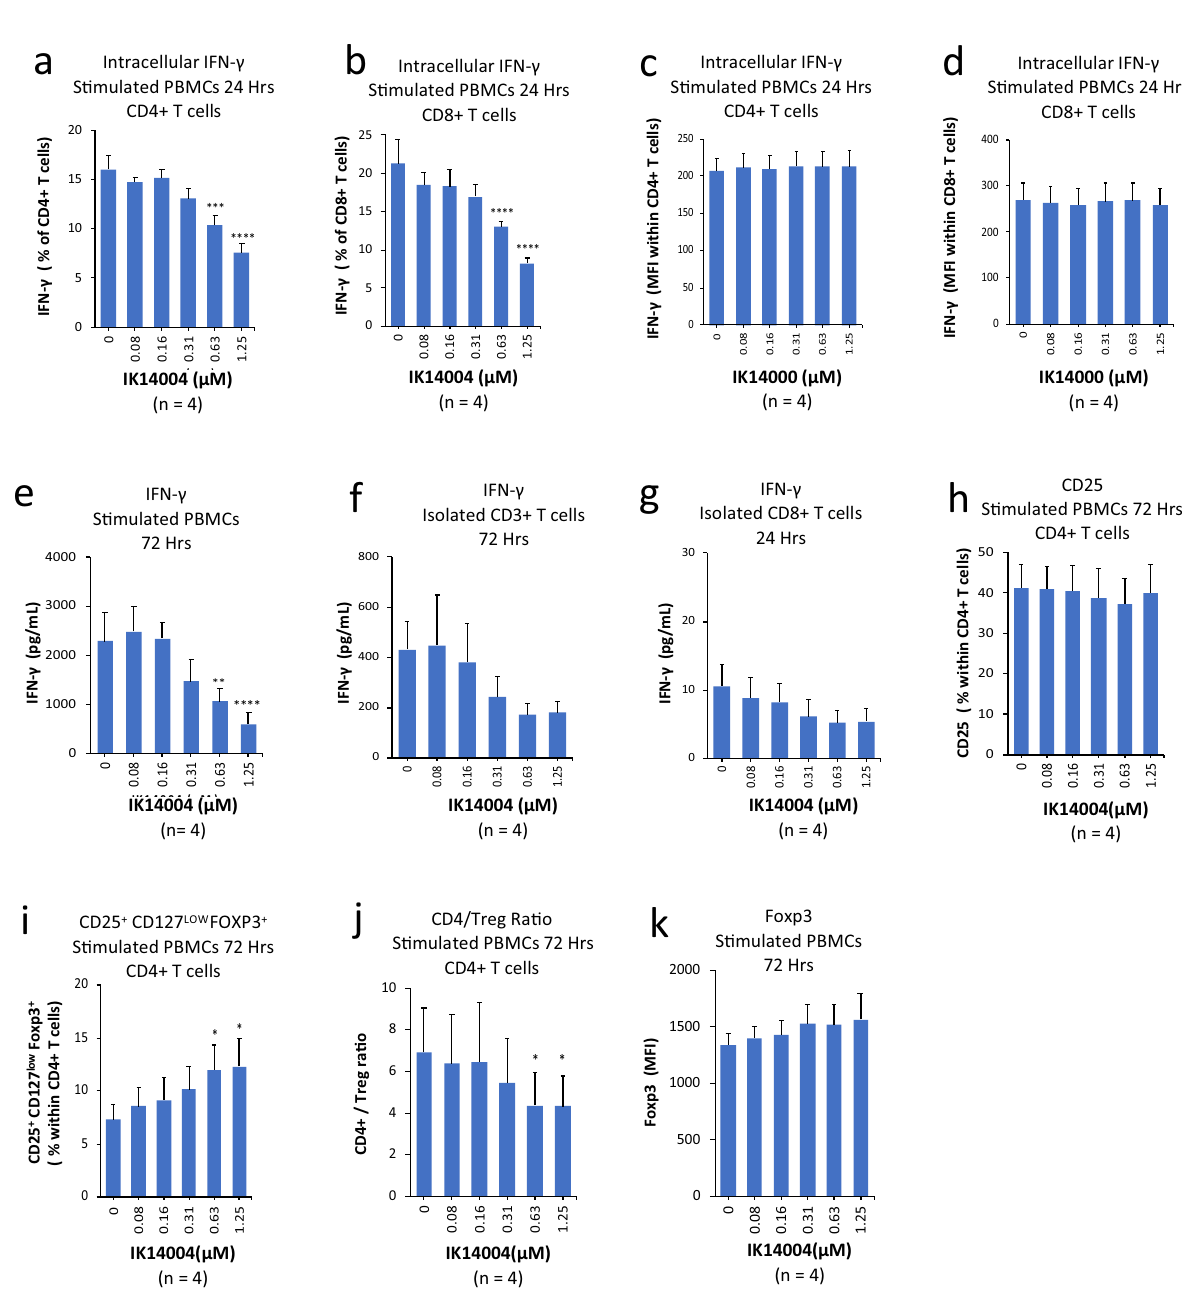
Figure 5. IK14004 inhibits IFN-γ expression and increases the proportion of T regulatory (Treg) cells. Stimulated PBMCs, isolated CD3+ T cells, or isolated CD8+ T cells were cultured in triplicate wells in each experiment. Each experiment was repeated four times (n = 4) as shown below each panel. Both flow cytometry and ELISA assays were conducted to assess IFN-γ expression either after 24 or 72 h. The compounds tested, IK14004 and IK14000, are listed under each panel. All error bars represent standard error of the mean (SEM). Flow cytometry data are shown as mean fluorescence intensity (MFI) and percentage values as indicated in the panels. Dot plots and gating strategies are shown in Supplementary Figs. S28 to S35. ( a ) Percentage of CD4+ T cells expressing intracellular IFN-γ within PBMC cultures exposed to the lipidic peptide, IK14004, for 24 h. ( b ) Percentage of CD8+ T cells expressing intracellular IFN-γ within PBMC cultures exposed to IK14004 for 24 h. ( c ) Intracellular expression of IFN-γ in CD4+ cells within PBMCs cultured for 24 h in the presence of RSKAKNPLYR (IK14000) that lacks the dodecanoic acid moiety. ( d ) Intracellular expression of IFN-γ in CD8+ cells within PBMC cultures exposed to IK14000 for 24 h. ( e ) Levels of IFN-γ within supernatants from PBMC cultures exposed to IK14004 for 72 h. ( f ) Levels of IFN-γ within supernatants from isolated CD3+ T cell cultures exposed to IK14004 for 72 h. ( g ) Levels of IFN-γ within supernatants from isolated CD8+ T cell cultures exposed to IK14004 for 24 h. ( h ) Percentage of CD25 + CD4 + T cells within PBMC cultures exposed to IK14004 for 72 h. ( i ) Percentage of CD4 + CD25 + Foxp3 + Treg cells within PBMC cultures exposed to IK14004 for 72 h. ( j ) The total CD4+: Treg cell ratio within PBMC cultures exposed to IK14004 for 72 h. ( k ) Expression levels of Foxp3 in CD25 + CD4 + T cells within stimulated PBMC cultures exposed to IK14004 for 72 h. Data were analysed using repeated measures (RM) two-way ANOVA with Dunnett’s post-test comparing peptide with vehicle control. *P < 0.05, **P < 0.01, ***P < 0.001, ****P <